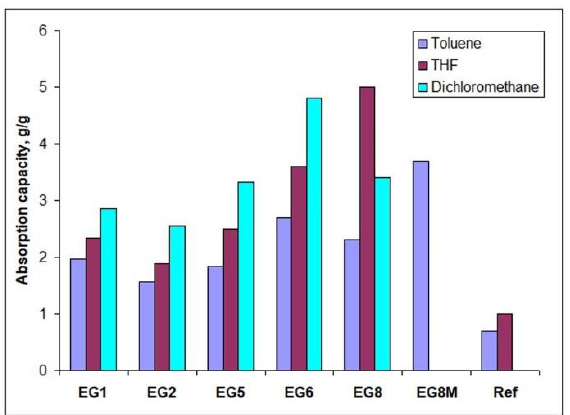
Figure 11. Absorption capacity (g/g) of xerogels after 30 min of immersion in different solvents.